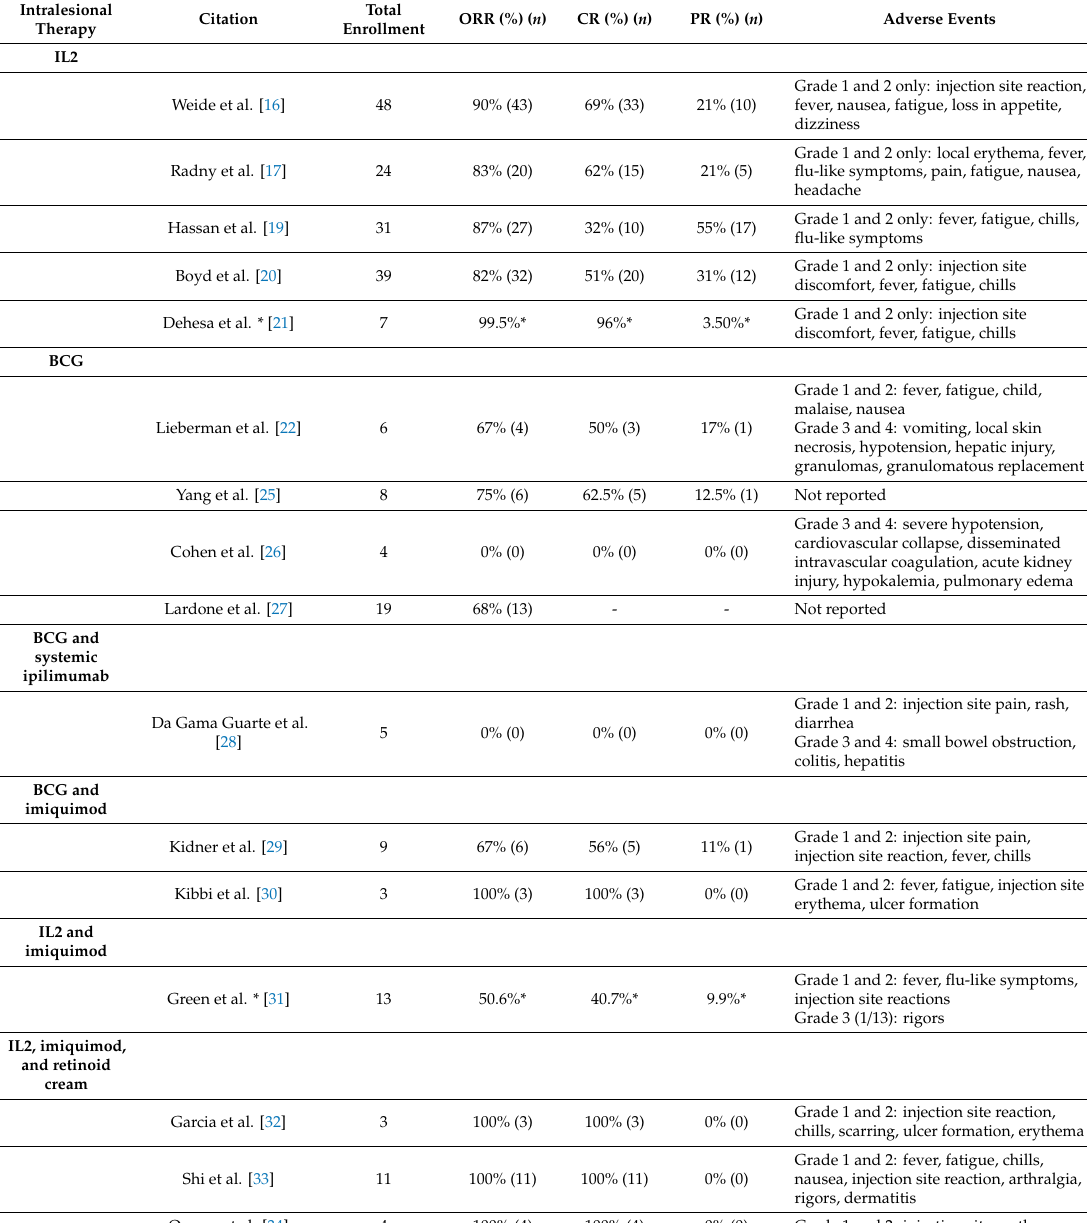
Table 1. A summary of the clinical responses and adverse events observed for the di ff erent intralesional therapies in major studies published to